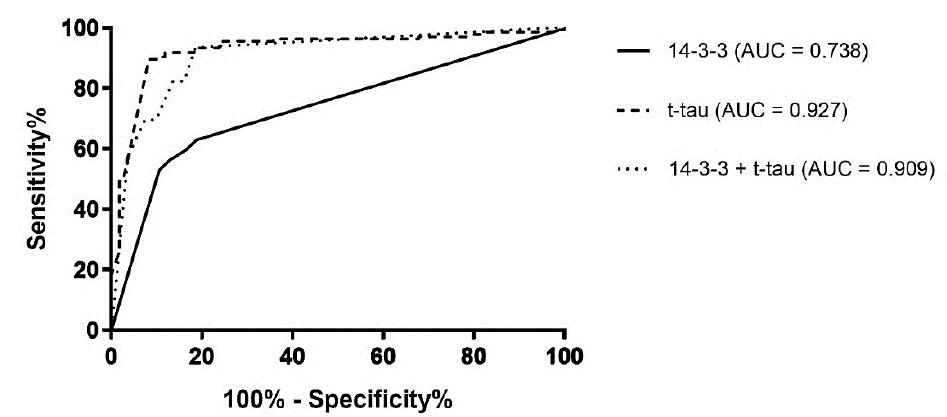
Figure 1. ROC diagrams for protein 14-3-3 positivity (solid line), t-tau values higher than 1200 pg/mL (dashed line), and the combination of protein 14-3-3 positivity and t-tau values higher than 1200 pg/mL (dotted line) in prion vs. non-prion disease cases. t-tau—total tau; AUC—area under the curve.